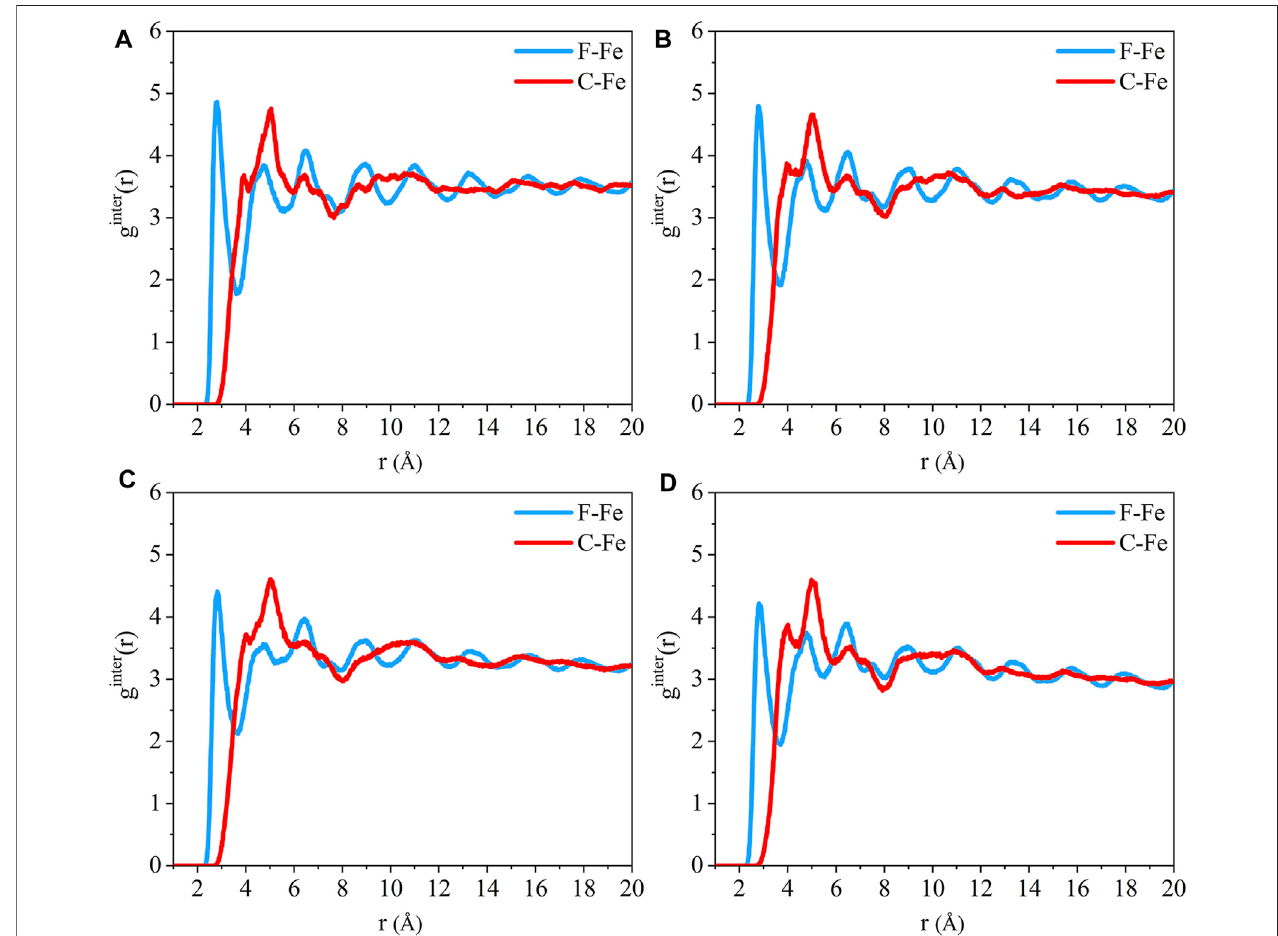
FIGURE 13 | Radial distribution function of the F-Fe and C-Fe pairs for the (110)/PTFE interface system under various temperatures: (A) 25 ° C, (B) 100 ° C, (C) 200 ° C, and (D) 300 ° C.